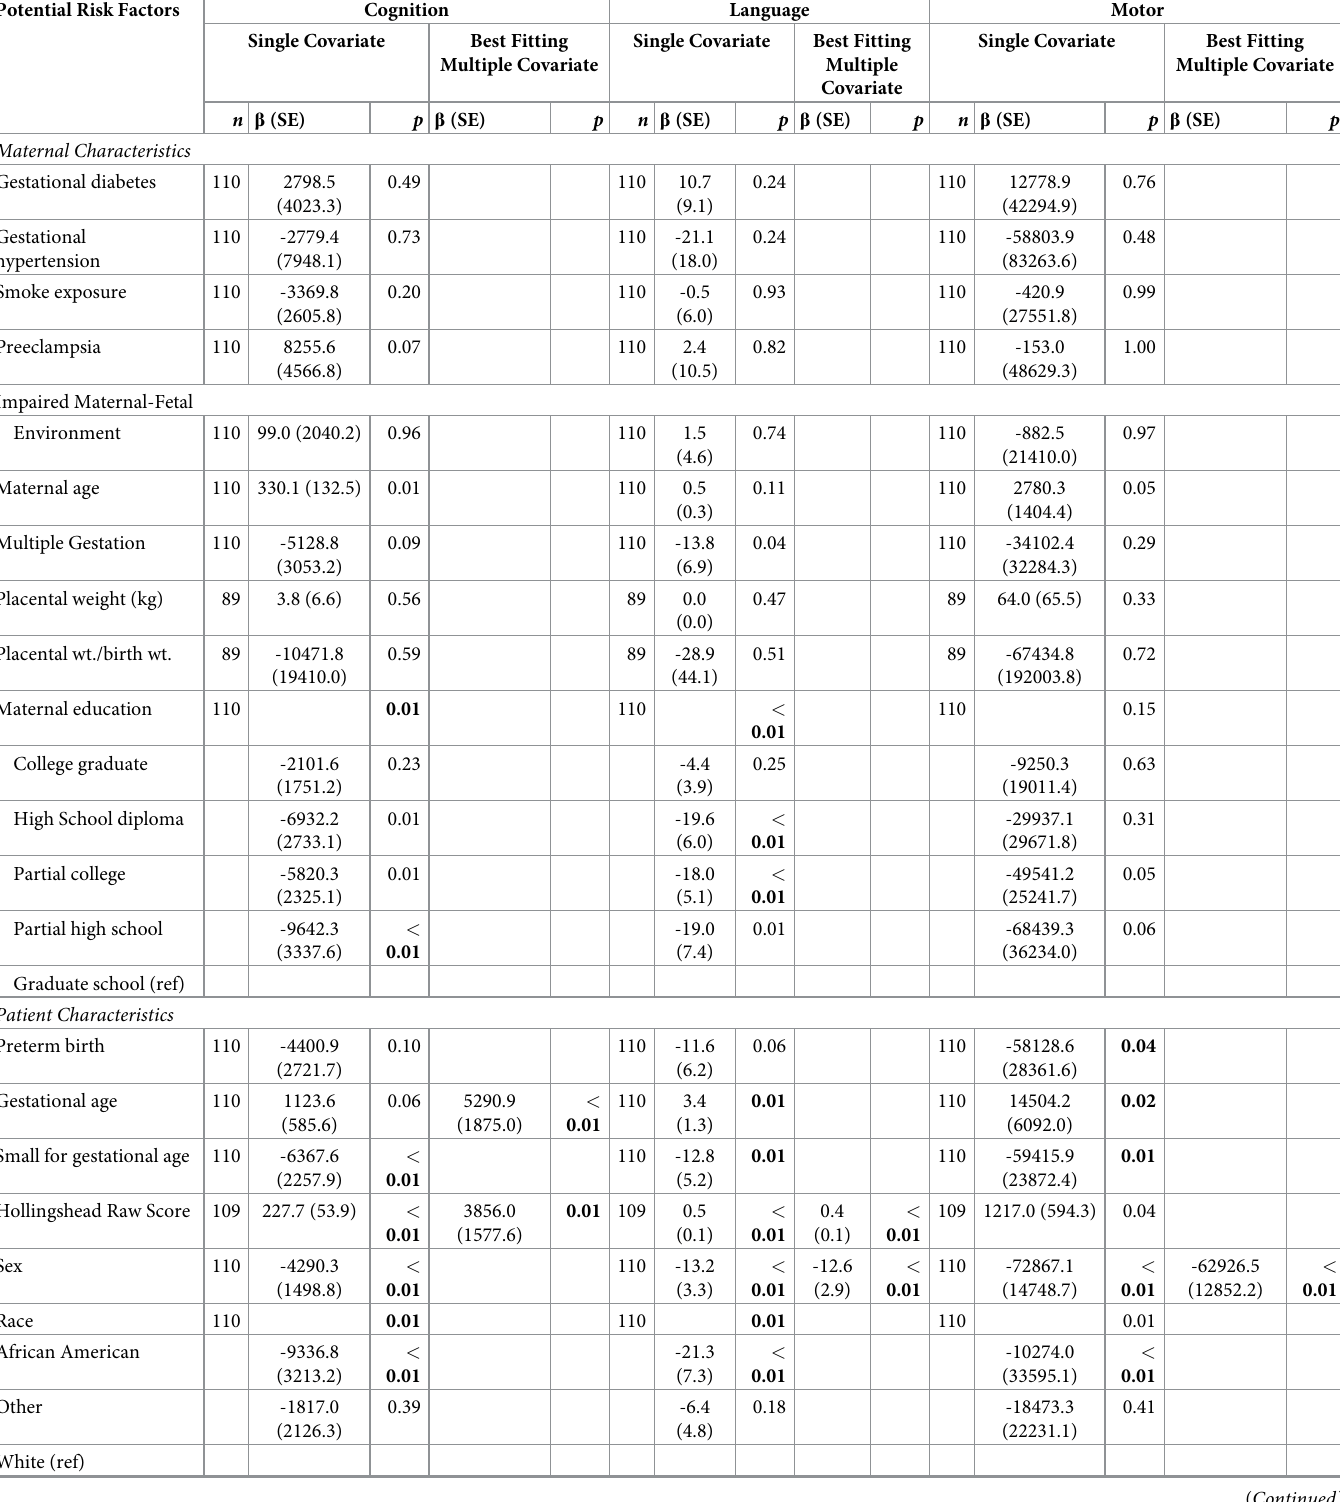
Table 3. Single and multiple covariate risk factor models for neurodevelopmental outcomes (N =